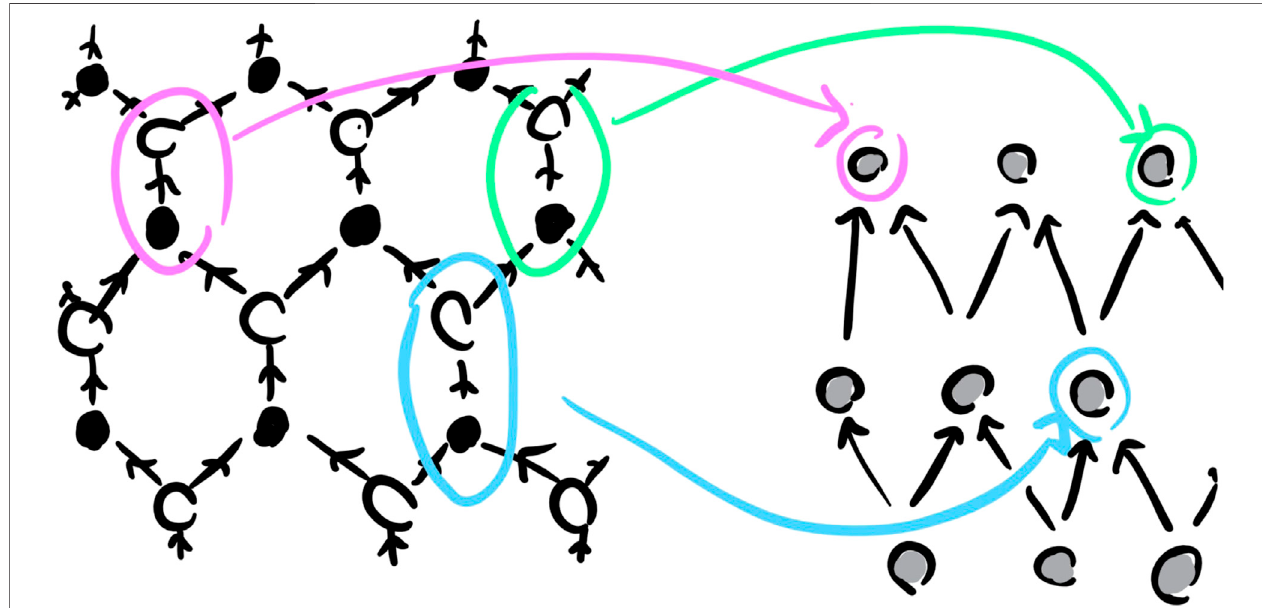
FIGURE 5 | Causal quotient from the honeycomb lattice to the diamond lattice. The pre-images of three events from the diamond lattice are highlighted.